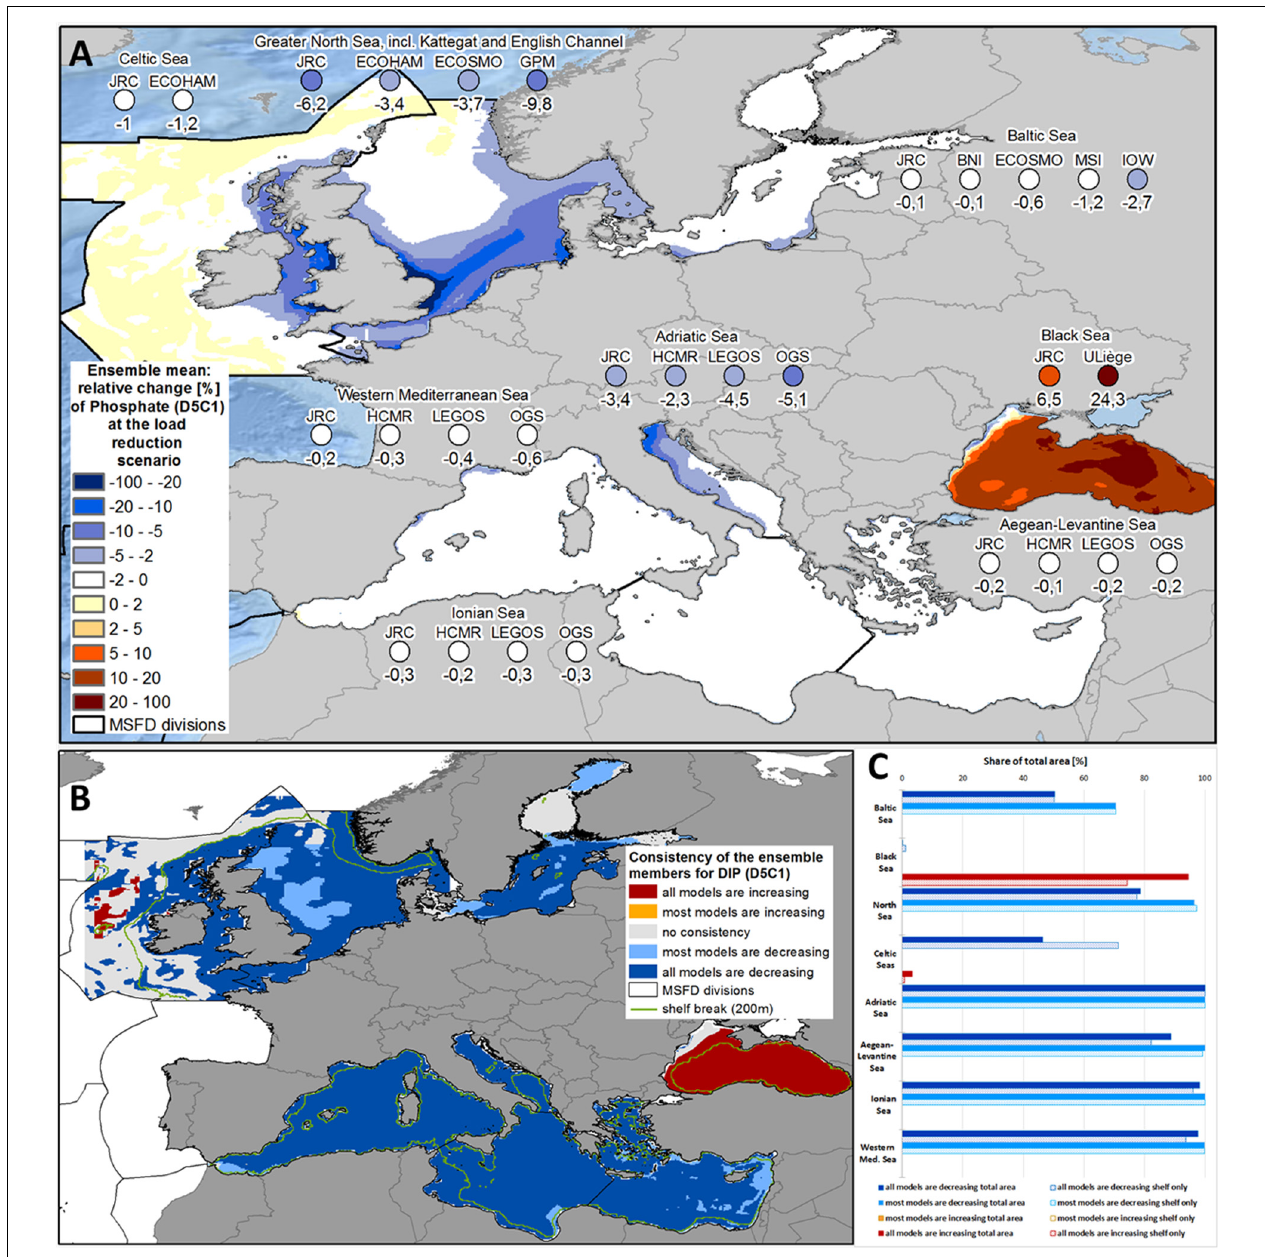
FIGURE 3 | (A) Ensemble means and model-specific relative change at load reduction scenario (compared to reference scenario) for the MSFD regions of phosphate (MSFD indicator D5C1). (B) Consistency map showing, if all or at least most models have the same trend of the relative change at load reduction scenario (compared to reference scenario) with respect to phosphate (MSFD indicator D5C1). (C) Share of the total area (bold bars) and of the shelf region (dotted bar), where all or most models show consistent changes with respect to phosphate (MSFD indicator